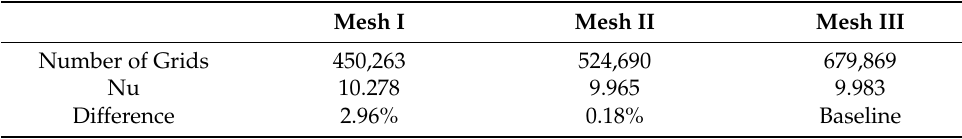
Table 2. Grid Verification